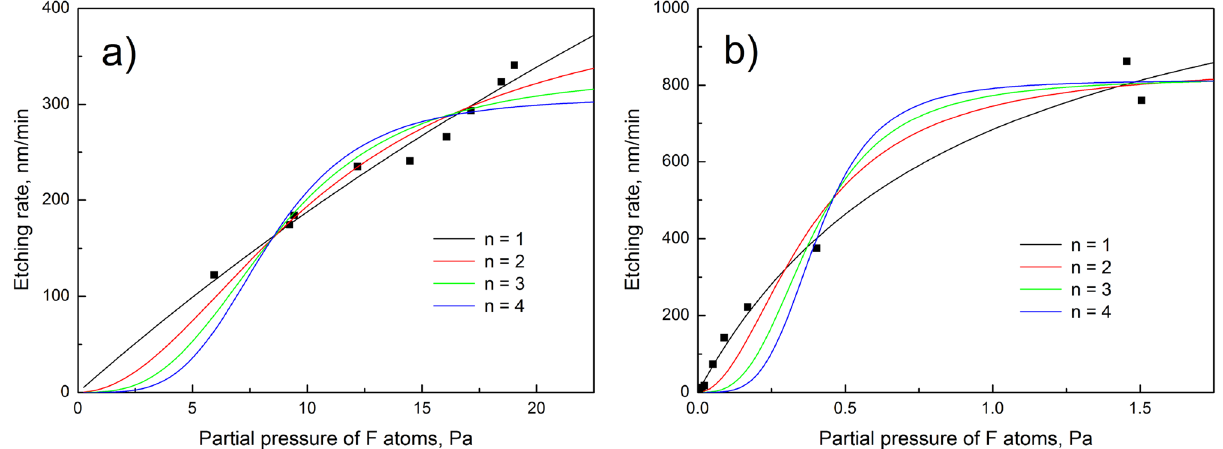
Figure 1. The experimental dependences of silicon etching rate on the partial pressure of F atoms fitted using Origin Pro software: ( a ) experiment 17 , ( b ) experiment 18